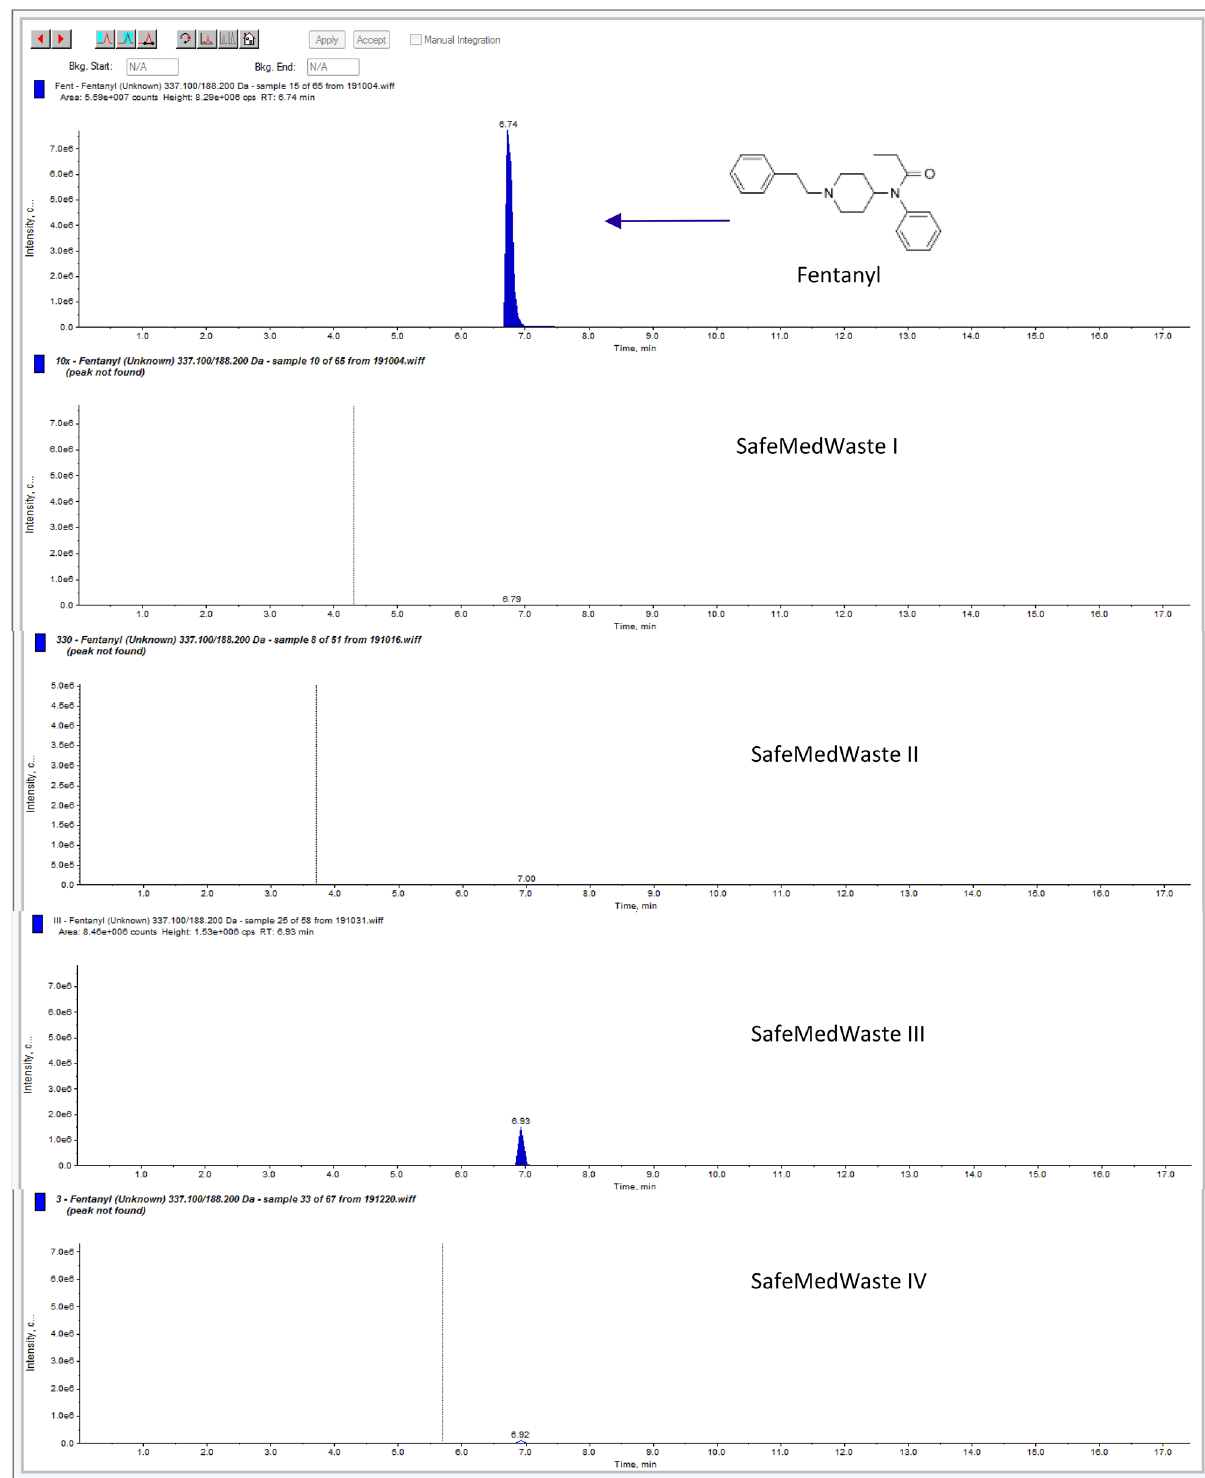
Figure 1. Denaturing fentanyl in SafeMedWaste. This figure shows LC–MS chromatograms of the fentanyl peak in control sample (top panel) and after SafeMedWaste I–IV (second from top to bottom panel). The fentanyl peak remained above the detection limit of 1 ng/mL in SafeMedWaste III but was denatured in the other three